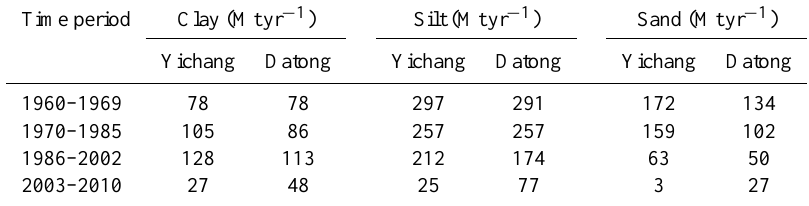
Table 3. Annual quantities of clay, silt, and sand at the Yichang and Datong stations during different periods. Time